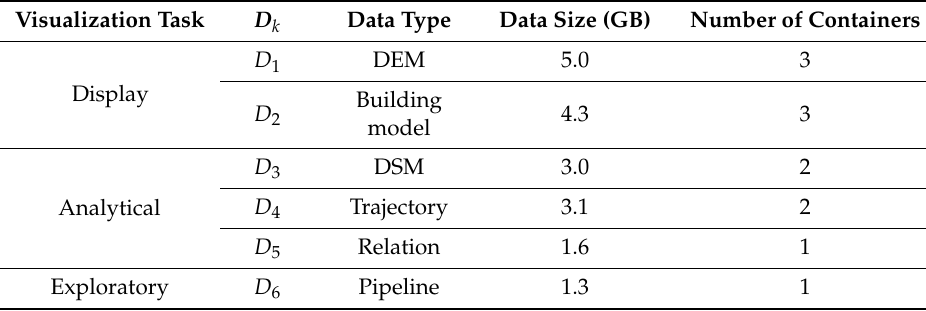
Table 1. Description of experimental